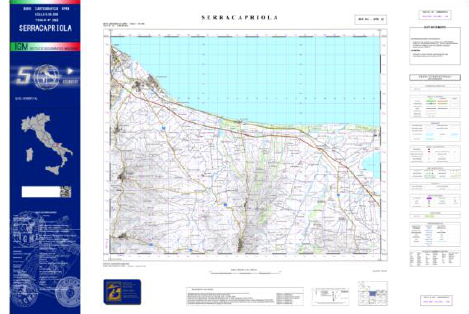
Figure 3. Example of 50_OPEN map